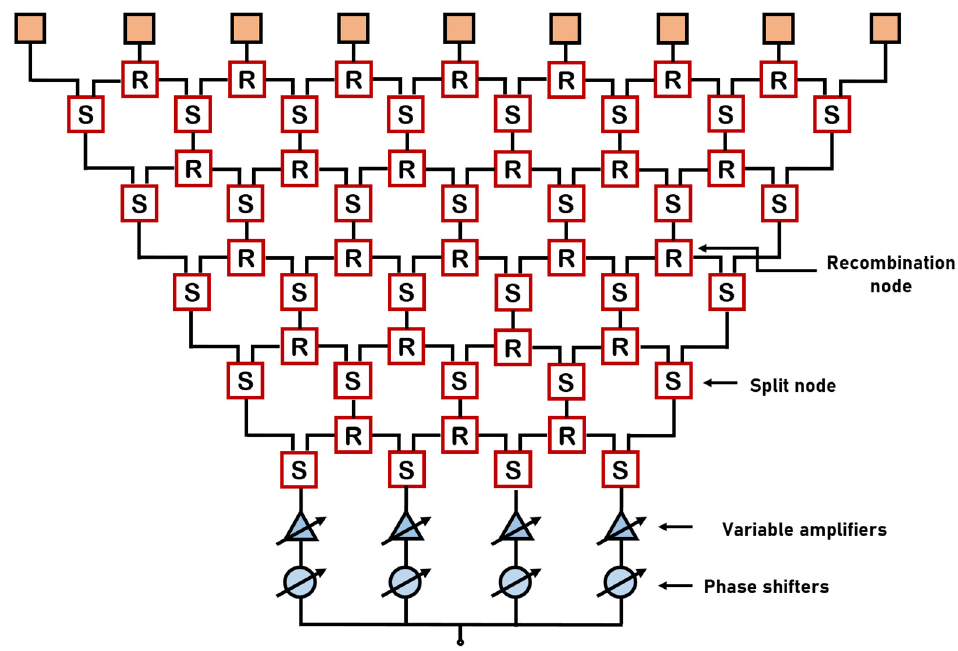
Figure 1. Standard scheme for a CORPS feeding network of 9 elements and 4 input ports.